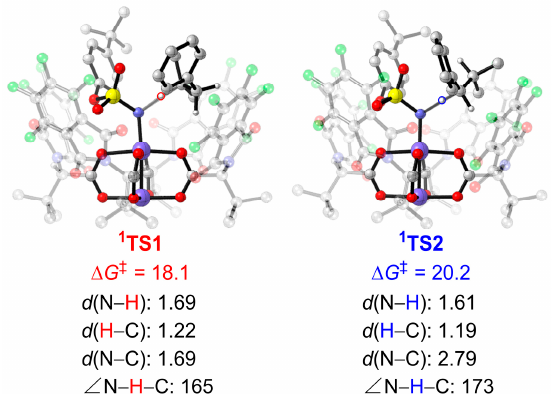
Figure 6. Optimized geometries and energies of 1 TS1 and 1 TS2 . The distances are in Å, the angles are in degrees, and energies are shown in kcal mol − 1 . Free energy obtained at the ONIOM (M06/def2 − TZVP:UFF//BPW91/6 − 31G* − LANL2DZ:UFF) level. The H atoms of t Bu groups and aryl groups are omitted for clarity.